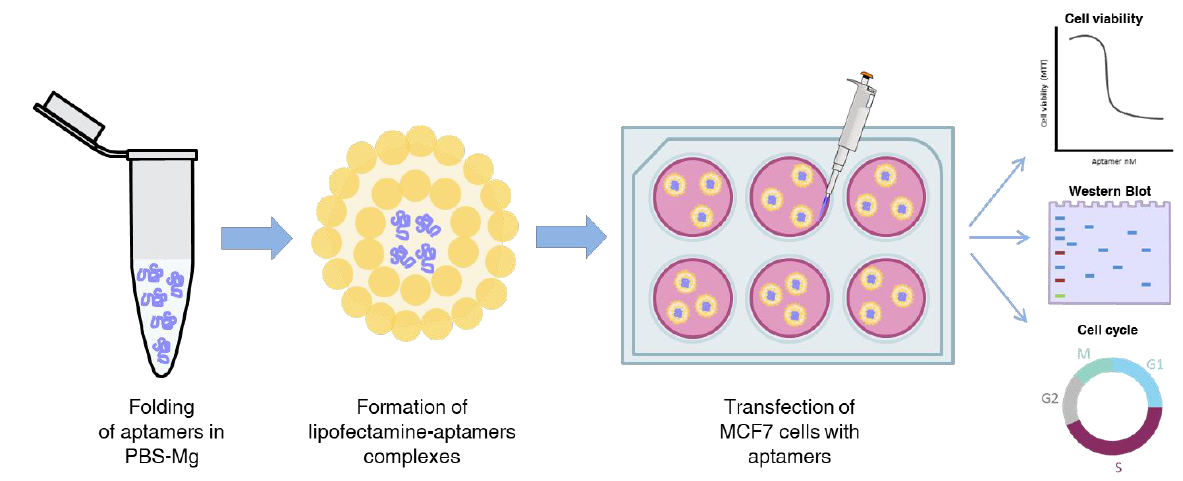
Figure 7. Workflow of aptamers preparation and treatment of MCF7